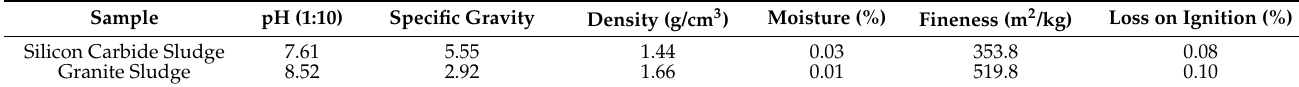
Table 1. T Basic characteristics of SiC sludge and GS.